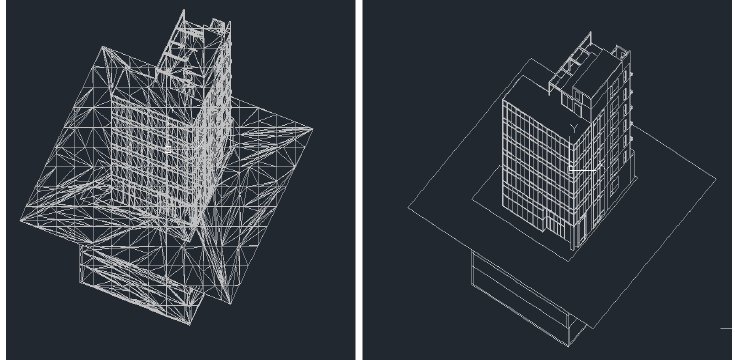
Figure 6. Hidden line removal (example image).